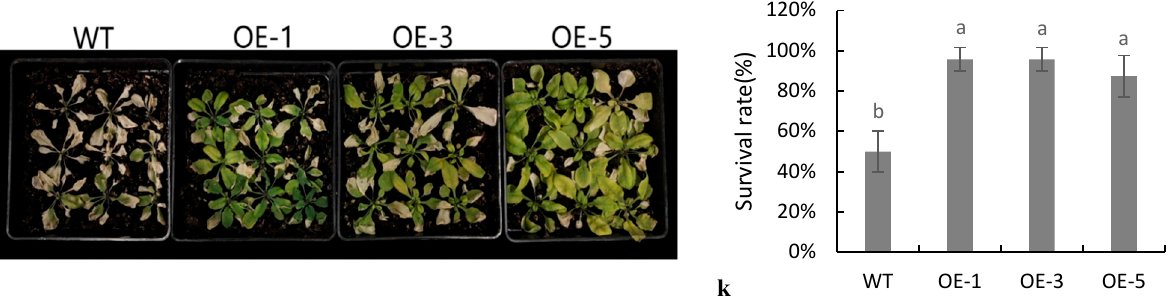
Figure 6. Comparison of transgenic Arabidopsis germination under different stress treatments. Response of transgenic Arabidopsis treated with ( a – c ) mannitol, ( d – f ) ABA, and ( g – k ) salt. ( a , d , g ) Germination rate, ( b , e , h ) root length, ( c , f , i ) root length data analysis, ( j ) salt stress at seedling stage, and ( k ) survival rate. WT: wild type. OE: SiNF-YC2 transgenic Arabidopsis. Bar = 1.5 cm. Different letters on columns indicate significant differences at the level of 0.05. p < 0.05 indicates significant differences between statistical data, p > 0.05 indicates insignificant differences between sta- tistical data, and p < 0.01 indicates extremely significant differences between statistical data. Different lowercase letters indicate differences between different